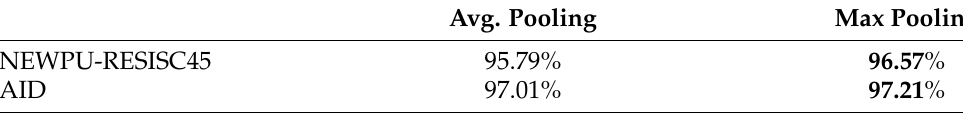
Table 1. Effect of average and max pooling. The highest score on each dataset is marked in bold.